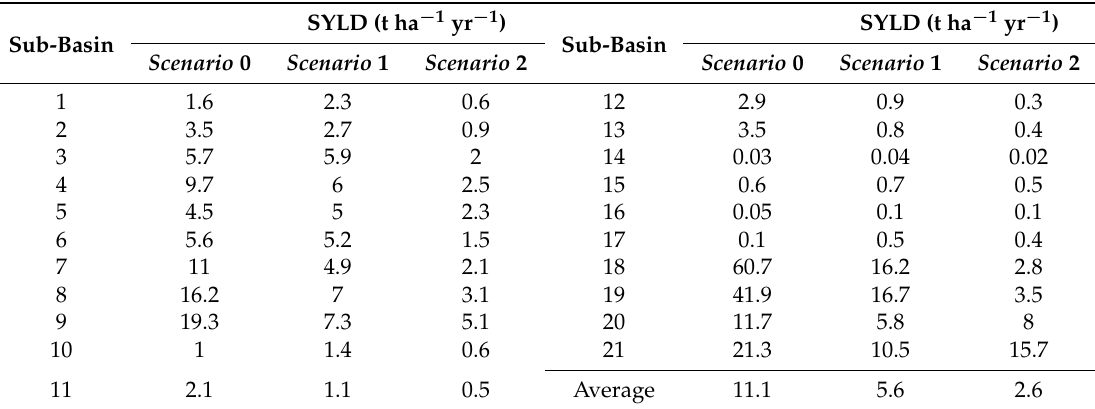
Note: SYLD means the sediment yield.